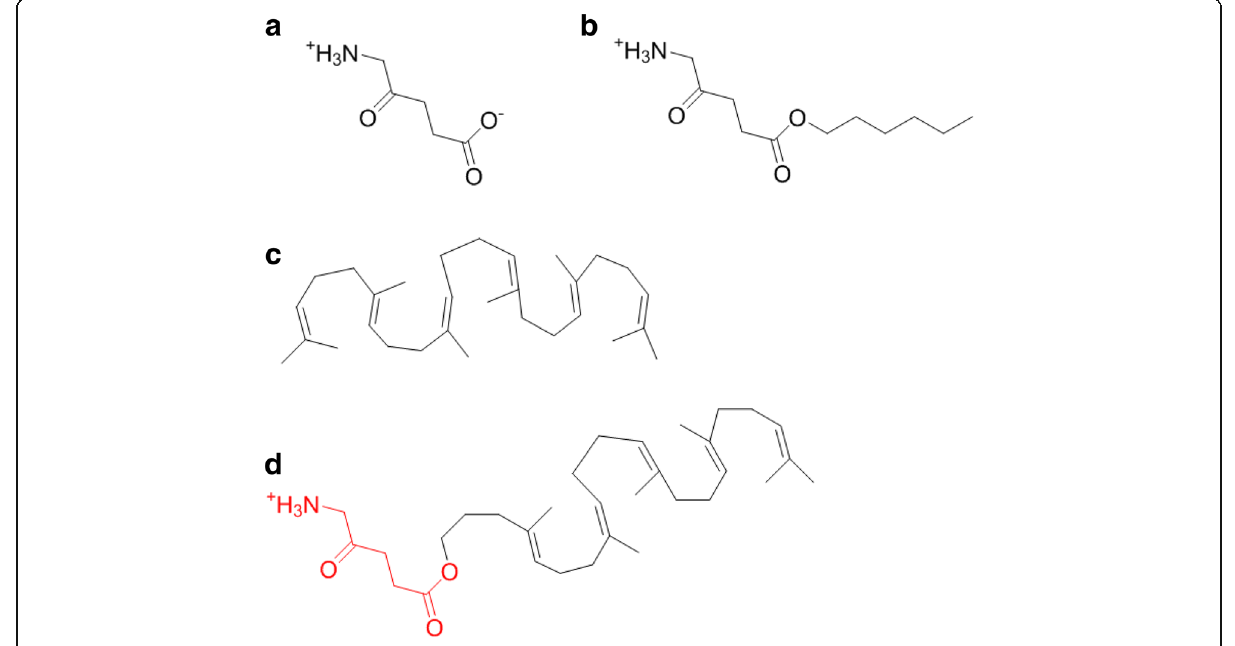
Fig. 1 Chemical structures of NA building block elements. 5-ALA ( a ), 5-ALA-Hex ( b ), squalene ( c ), and 5-ALA-SQ ( d